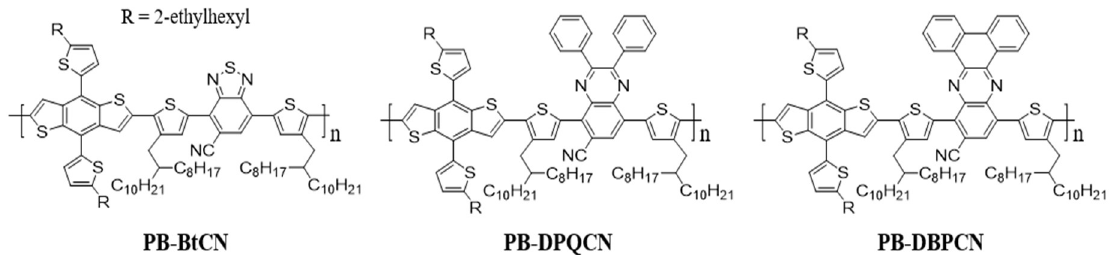
Figure 1. Chemical structures of PB-BtCN, PB-DPQCN, and PB-DBPCN.